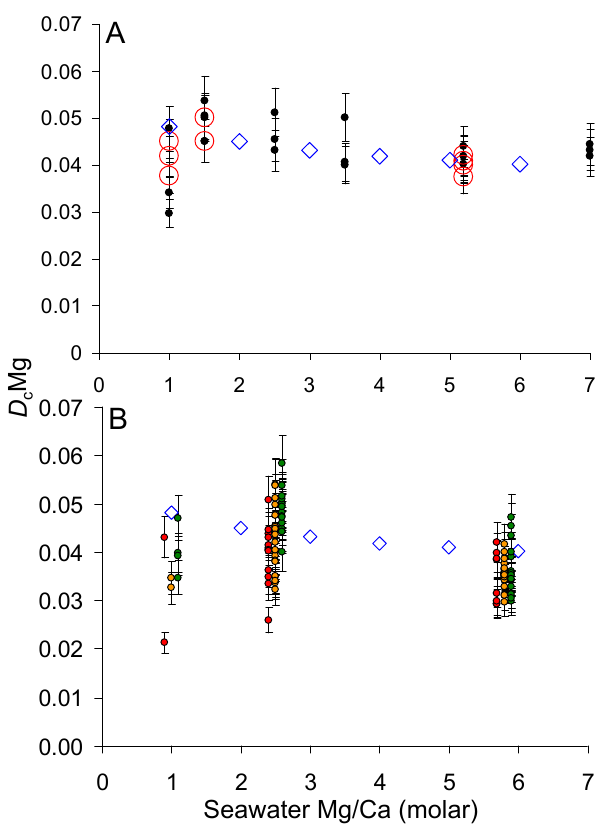
Fig. 21. Mg fractionation coefficients ( D c Mg) for (A) the encrust- ing coralline alga Neogoniolithon sp. and for (B) the three species of branching coralline algae Amphiroa A (closed red circles), Am- phiroa B (closed orange circles), and Amphiroa rigida (closed green circles) reared in the experimental seawater treatments formulated at Mg/Ca ratios ranging from 1.0 to 7.0 (from Ries, 2006b; Stanley et al., 2002). D c Mg is calculated as Mg/Ca C divided by Mg/Ca sw . Large open red circles in (A) correspond to D c Mg for the second set of experimental seawaters with Mg/Ca ratios of 1.0, 1.5, and 5.2 that have reduced (1.0, 1.5) and elevated (5.2) absolute concen- trations of Mg 2 + and Ca 2 + , respectively. These results indicate that D c Mg varies with Mg/Ca sw . However, changes in the abso- lute Mg 2 + concentration of seawater had no significant ( p < 0 . 05) effect on D c Mg when Mg/Ca sw was fixed with proportional eleva- tions in [Ca 2 + ]. Large open blue diamonds correspond to the D c Mg of abiotic calcite (F¨uchtbauer and Hardie, 1976).